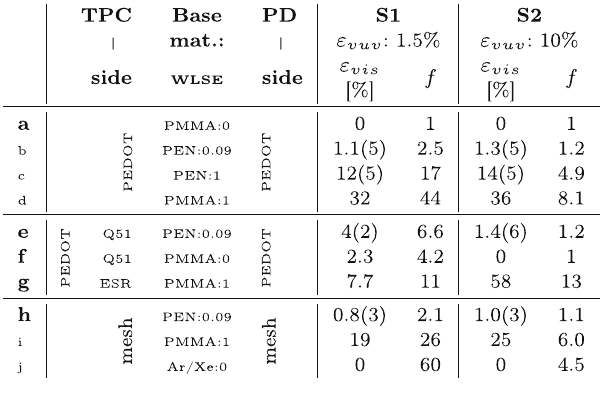
Table 1 Considered and fabricated (bold label) structures, detailing the TPC and photodetector (PD) sides, and base material configura- tions with the assumed base material WLSE (‘g’ so far prototyped only with non-WLS PMMA). Light collection efficiencies, ε v u v (VUV) and ε v is (visible), obtained from Geant4 simulations (Sect. 4), are given in the right columns (for ‘j’, which is a special case, ε S 1 v u v = 88% and ε S 2 v u v =45%). For the PEN base material, two visible light absorption lengths are considered, 1 cm and 5 cm, with the resulting central value andsystematicuncertaintygivenfor ε v is .Thefigureofmerit, f ,defined later in text, is also shown (central value only)